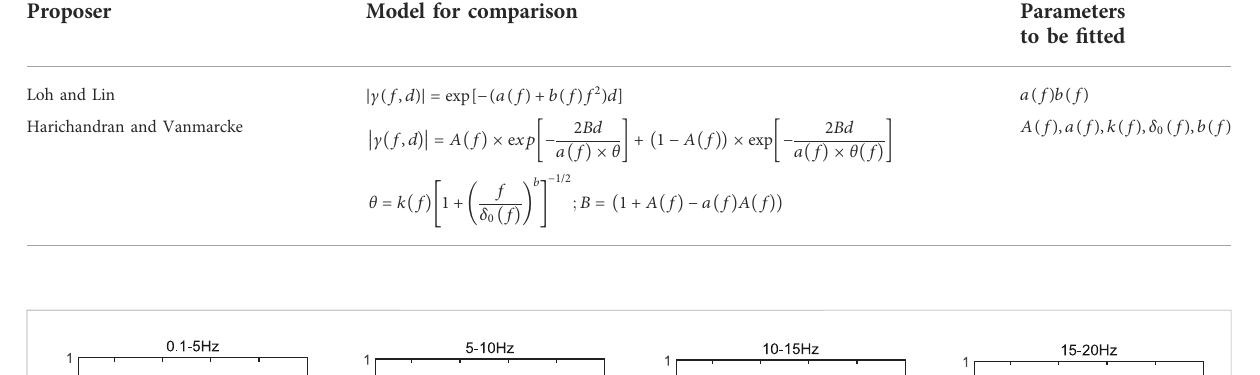
TABLE3Empiricallaggedcoherencymodelforcomparison(accordingtotheresearchcontentinthissection,themodelexpressionhadbeenslightly modi fi ed). Proposer